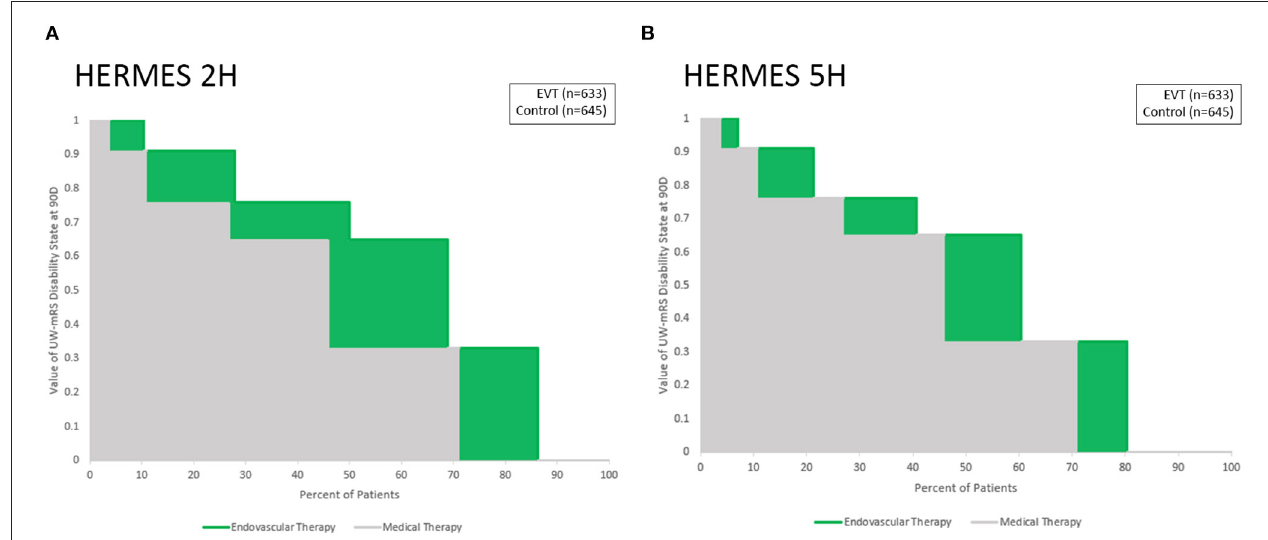
periods, while endovascular thrombectomy outcomes have greater differential additional value (green) with earlier treatment